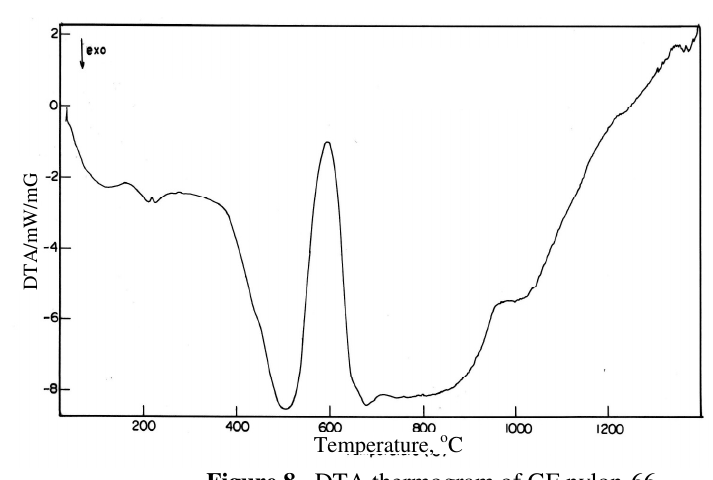
Figure 7. DTA thermogram of nylon-66